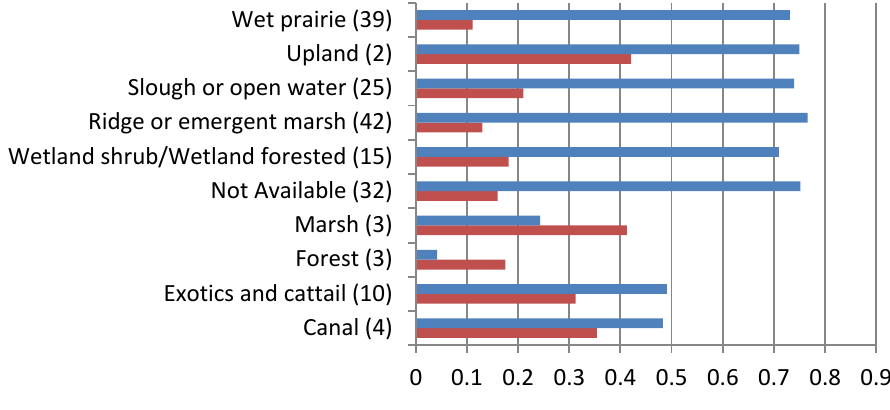
Figure 12. Mean agreement rates and agreement variation for gages grouped by field-determined community type. Values in parentheses represent the number of gages classified as that type. The number of observations for that type is larger given the 50-date study image database. Lowest agreements occurred in both upland (forest) and wetland (marsh) classes in which a minority of EDEN gages was located.